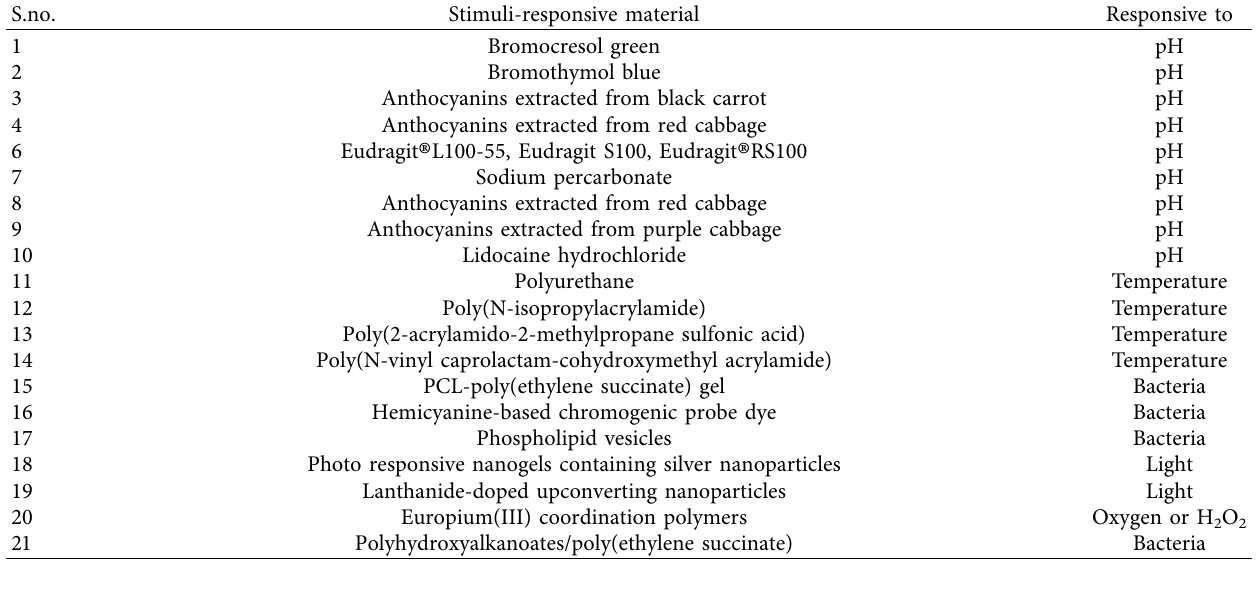
Table 1: Different stimuli-responsive materials are used in electrospun nanofibrous wound dressings. S.no.